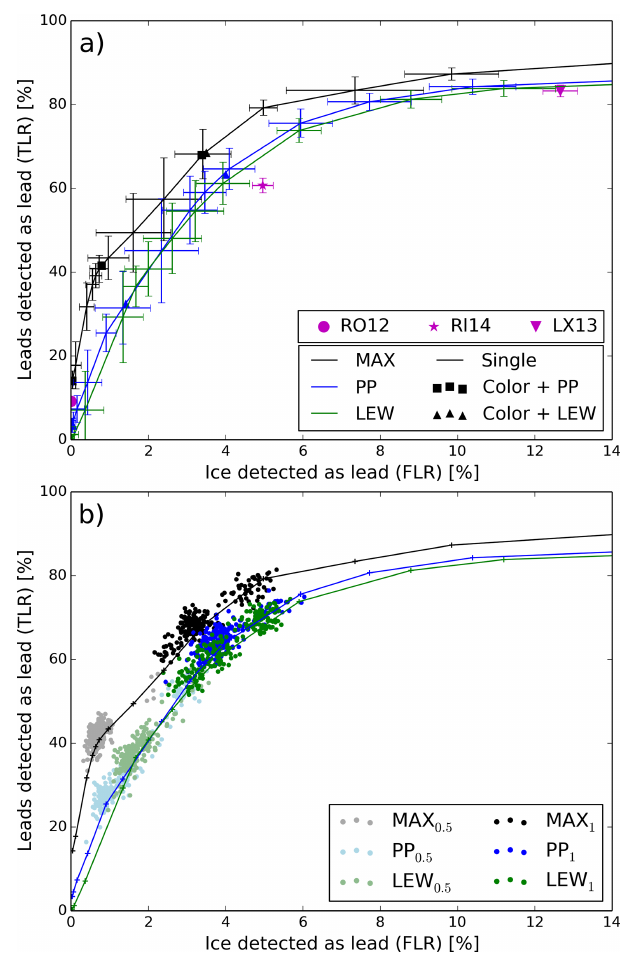
Figure 5. (a) ROC graph including error estimates in terms of SD of the 200 runs for each weight of the single-feature classifiers using the MAX, PP and LEW as well as the performances and SDs of the predefined classifiers. For comparison, the performances of selected two-dimensional classifiers are included. (b) Performances of each individual run being part of the single-feature classifiers using the MAX, PP and LEW with weights of 0.5 and 1 (dots) in combination with mean values for all weights (lines).